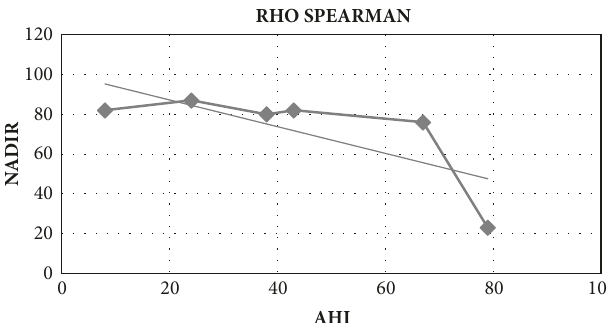
Figure 2: NADIR versus AHI. Relationship: Rho Spearman coefficient . An inverse correlation was documented between the data for AHI and NADIR, according to the Rho Spearman coefficient